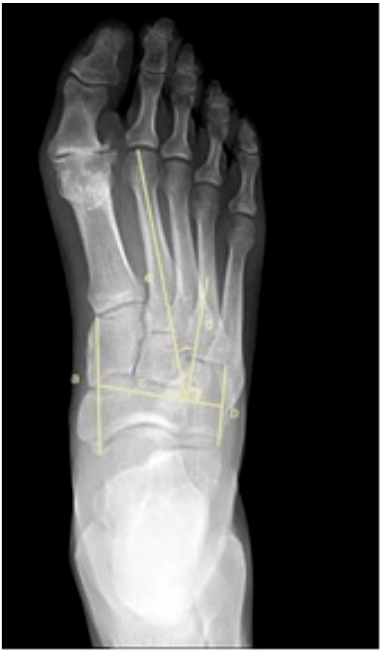
Figure 1. Dorsoplantar weightbearing radiograph of Sgarlato’s angle. Modified Sgarlato’s [18,30–32], Figure 2, is the angle between the longitudinal axis of the second metatarsal and the longitudinal axis of the lesser tarsus using the 5th metatarso- cuboid joint as a reference. Line (a) extends between the most lateral point of the 5th metatarso-cuboid and the calcaneo-cuboid joints. Line (b) extends between the most medial point of the talo-navicular and the medial cuneiform-first metatarsal joints. Line (c) extends between the midpoints of lines (a) and (b). Line (d) represents the longitudinal axis of